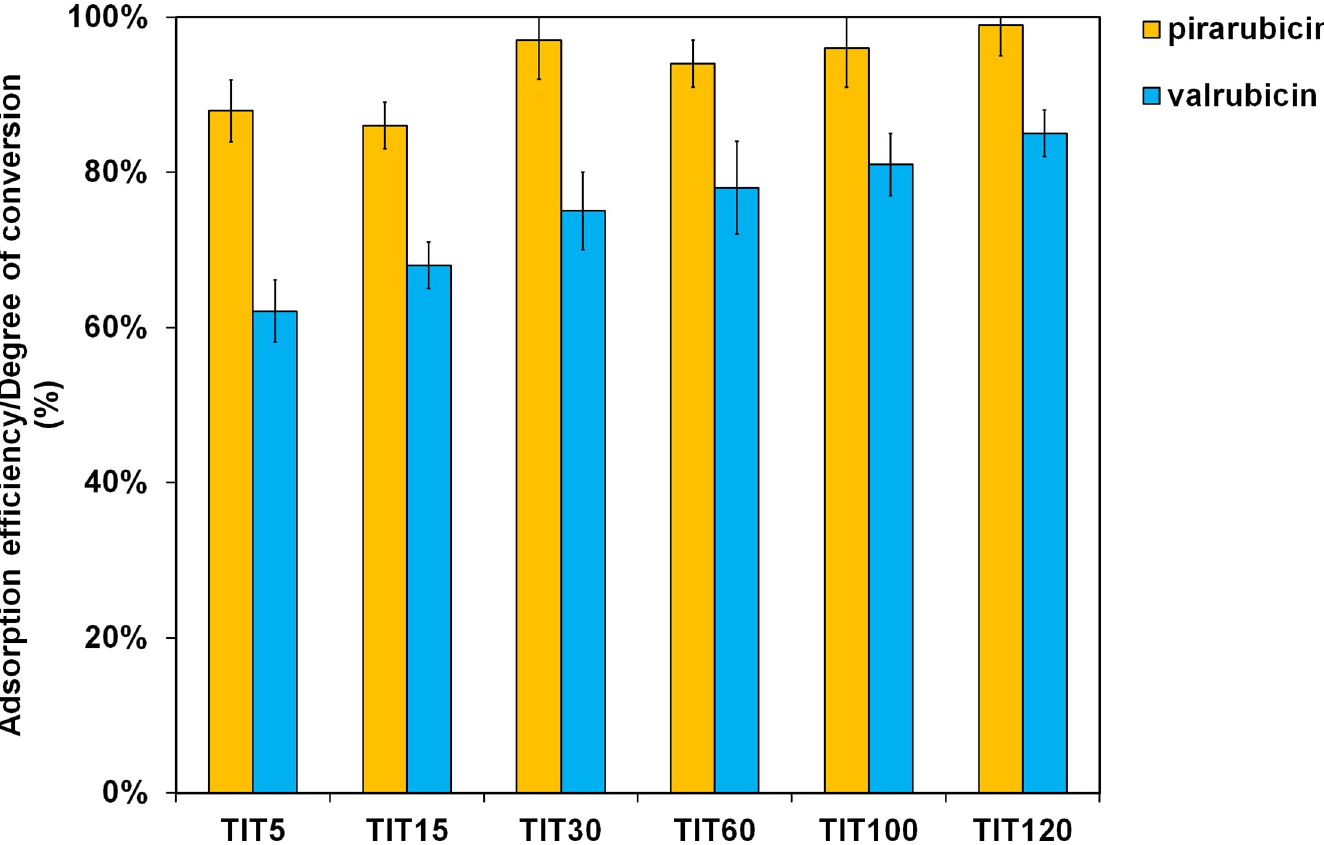
Fig 12. The degree of conversion of pirarubicin (a) and valrubicin (b) using the nanostructured TiO 2 -based adsorbents after 120 minutes.